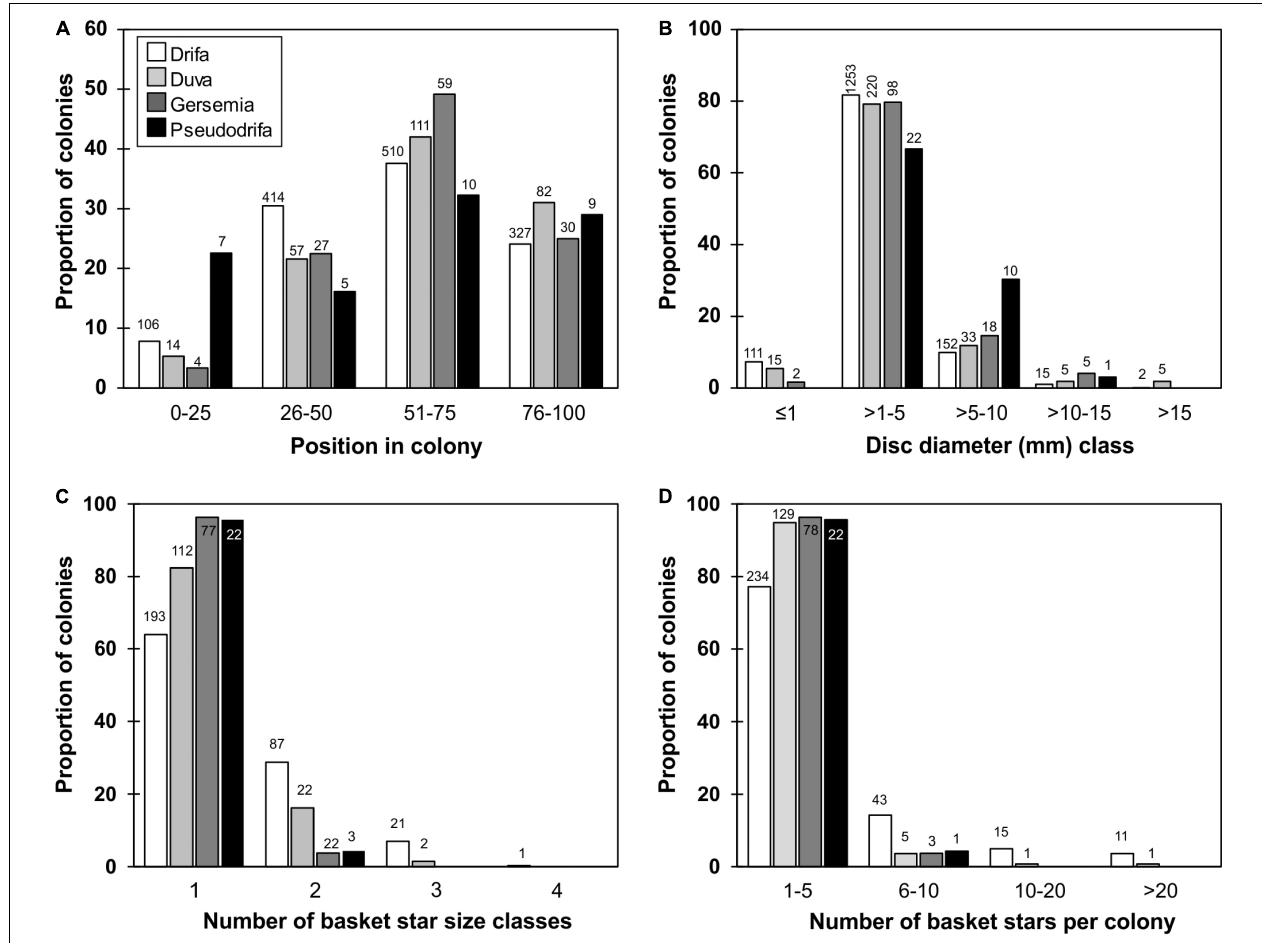
FIGURE 4 | Proportion of soft coral colonies by taxa in relation to: (A) basket star position on colony by quartiles of colony height (0 closest to base, and 100 closest to distal extremity of colony), (B) basket star disc diameter class, (C) maximum number of basket star size classes found on a single colony, (D) number of basket stars per colony. Number of specimens is shown on top of